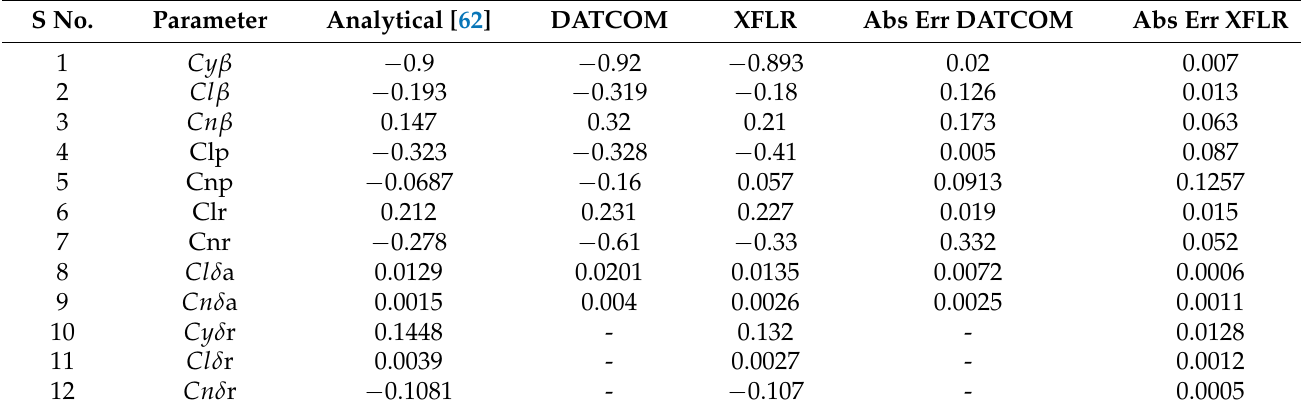
Table A2. Comparison of lateral stability aerodynamic coefficient